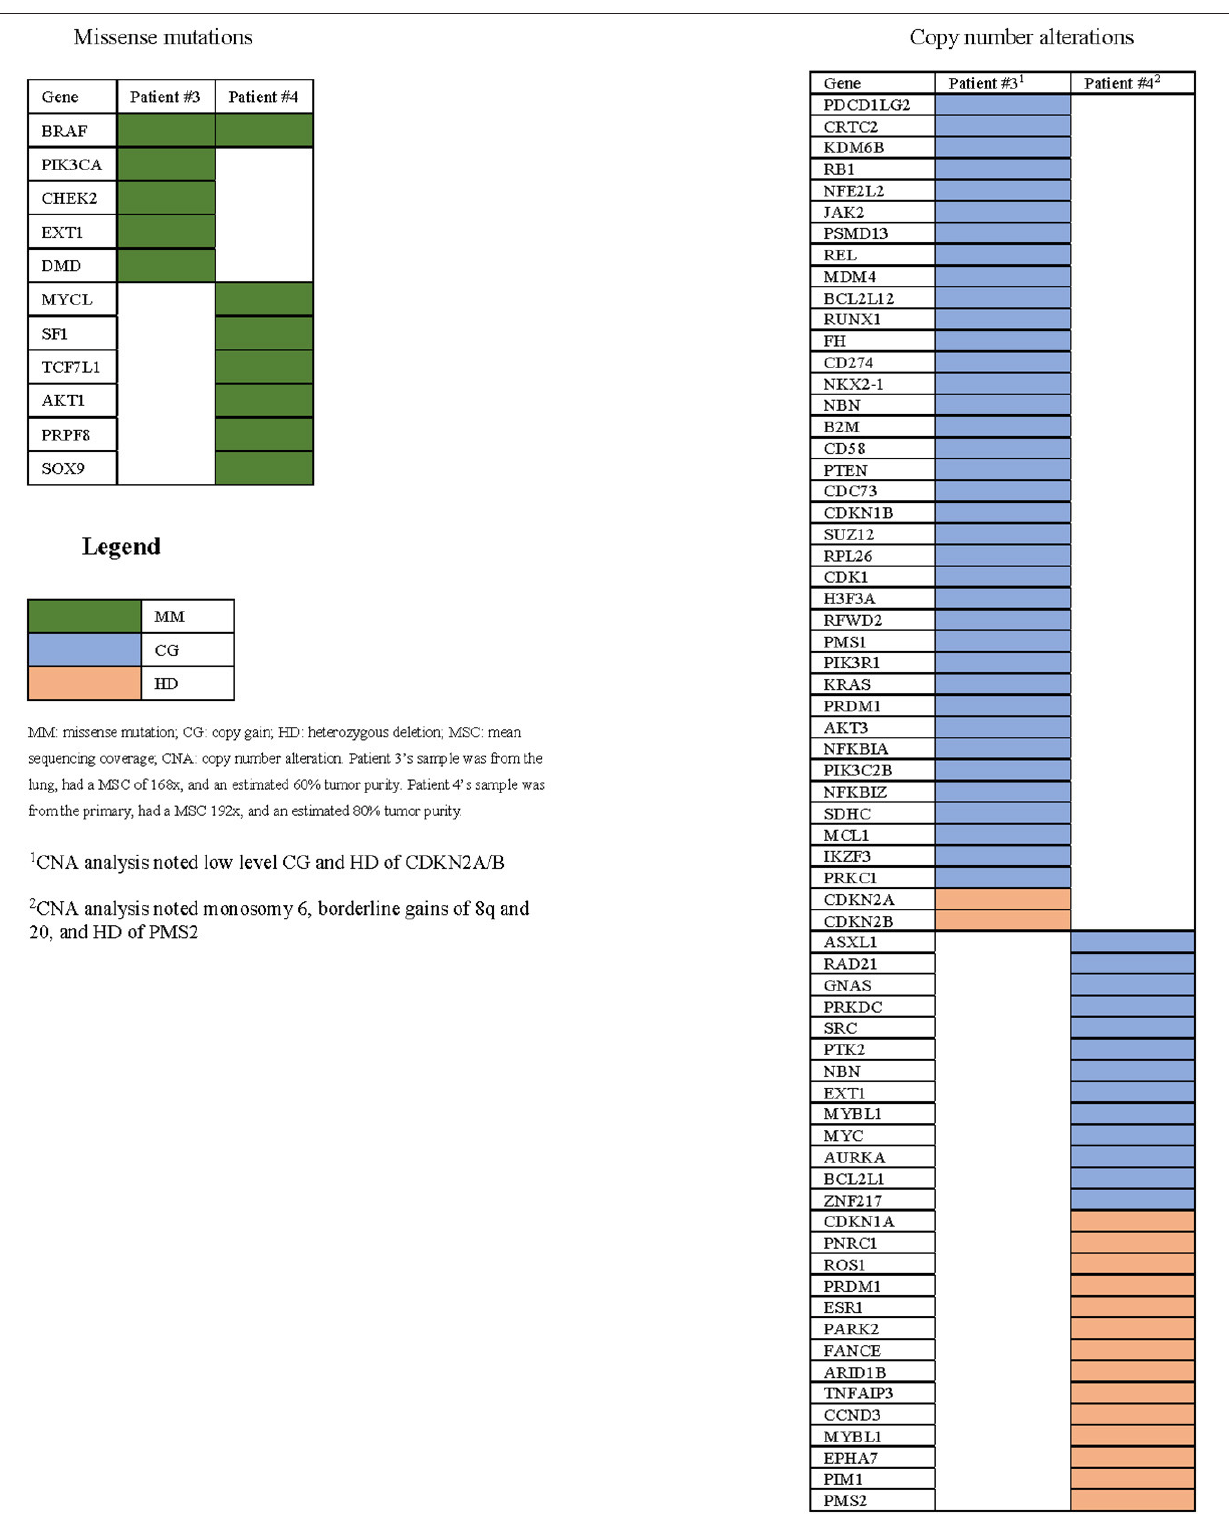
FIGURE 3 | All genomic alterations of patients with sequencing data available.